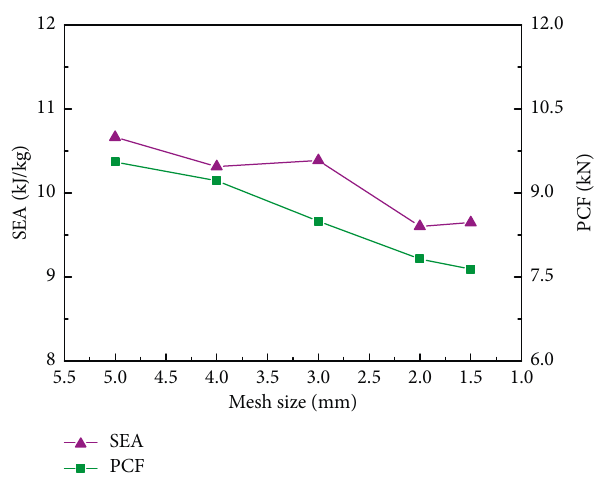
Figure 6: Element size convergence